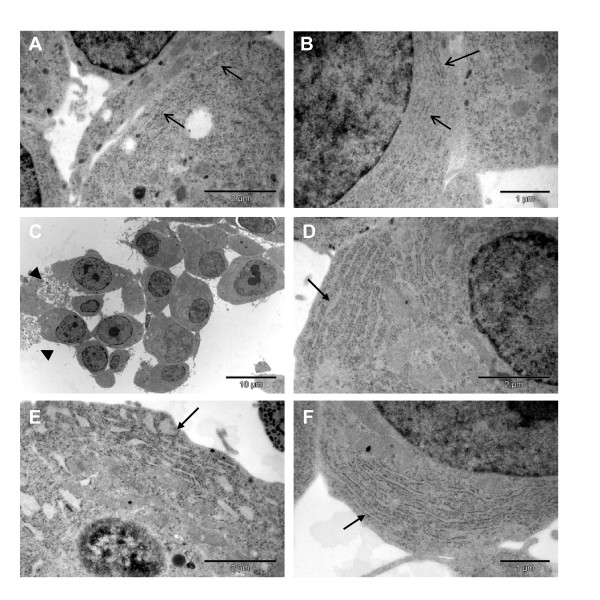
Effect of insulin 2 (C96Y)-EGFP expression on ER morphology. Clone #4S2 cells untreated (A, B) or treated with 2 μg/ml doxycycline for 3 days (C, D) or 6 days (E, F) were washed in PBS and fixed. The cells were processed for transmission electron microscopy as described in the methods. ER structures in uninduced cells (A, B, arrows), and distended ER structures in mutant insulin expressing cells following doxycyline-induction (D-F, arrows) are indicated. The presence of apoptotic cells was evident in doxycyline-induced cells (C, arrowheads).